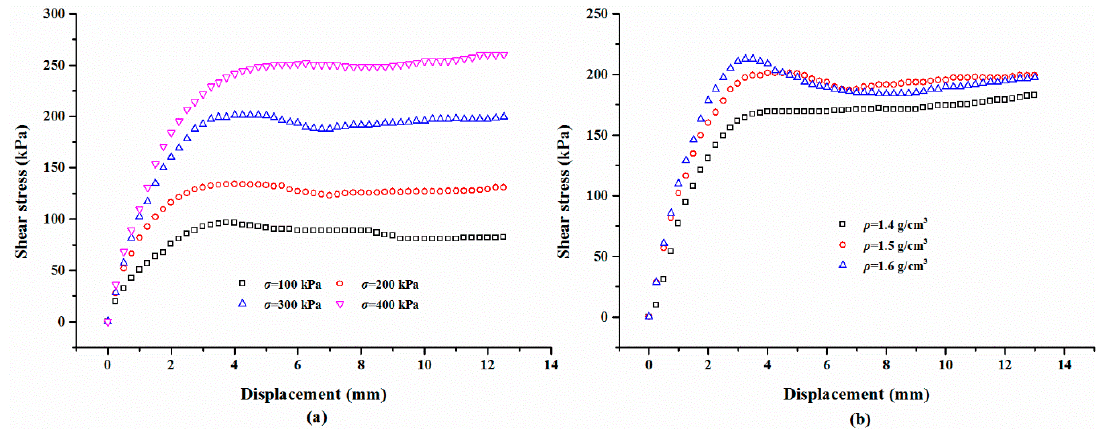
Figure 14. The presentative shear stress-displacement curves: ( a ) With different normal stress σ ; ( b ) With different dry density ρ .